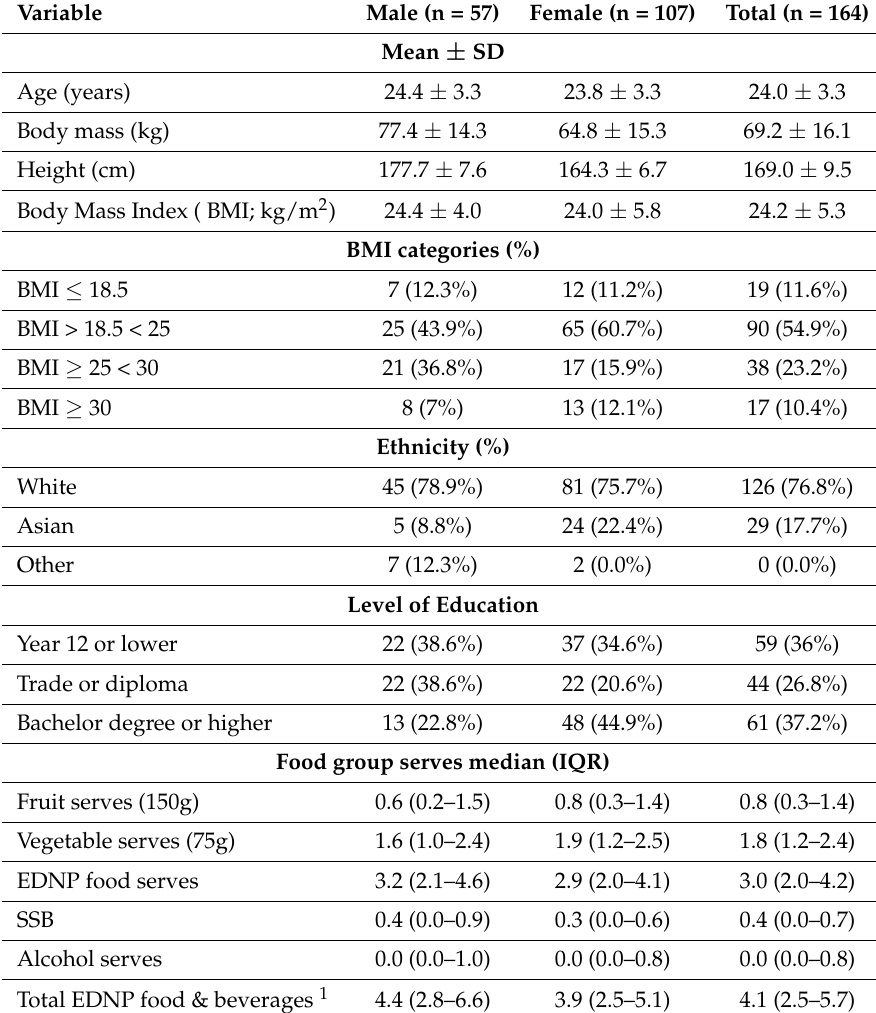
Table 1. Baseline characteristics of study participants randomized to receive the dietary feedback text messages (n =